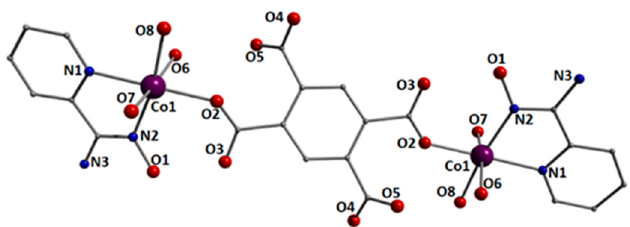
Figure 4. Representation of the molecular structure of the dinuclear complex 4 . Color code: Co 2 + , purple; N, navy blue; O, red; C, grey. The hydrogen atoms are omitted for clarity.